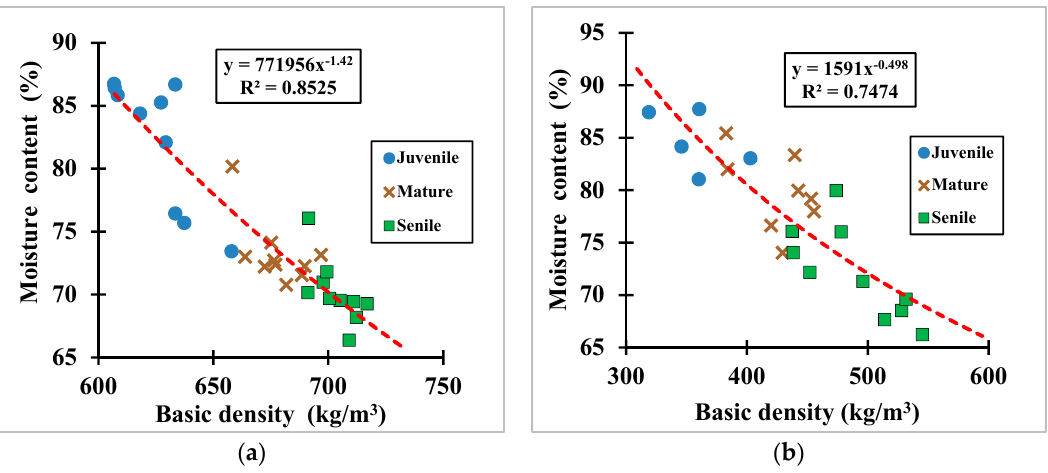
Figure 9. Basic density vs. green moisture content measured per wood group age for ( a ) the eucalyptus samples, and ( b ) the cypress samples.